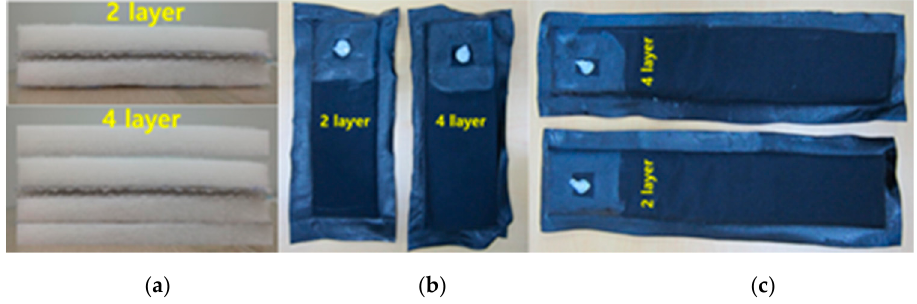
Figure 3. ( a ) Surface and lateral surface of nonwoven filler, and ( b ) structure of three-dimensional spacer fabric filler.